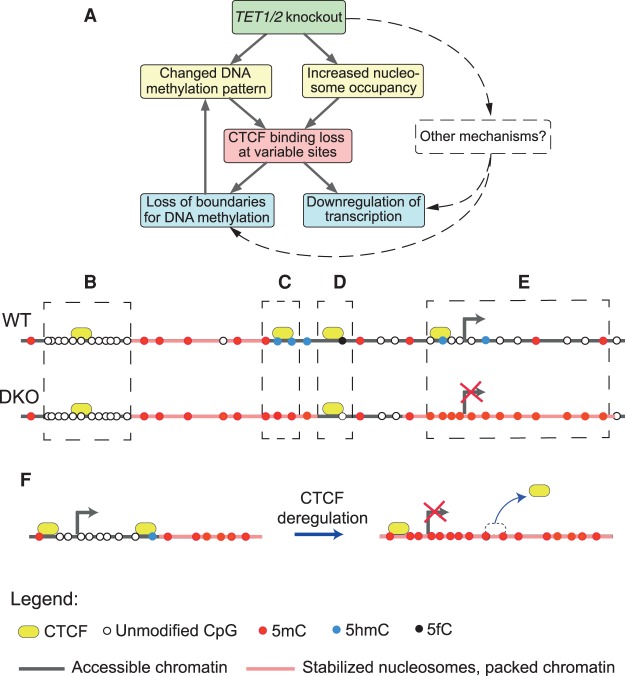
A scheme of different regimes of CTCF sensitivity to DNA modifications. (A) Simplified scheme of the possible causality of events: Tet1/2 knockout leads to the changed DNA methylation pattern and increased nucleosome occupancy. These lead to CTCF binding loss at variable sites. As a result, methylation spreads to larger areas, and neighboring genes are down-regulated. (B) Common CTCF sites were significantly enriched at CpG islands where DNA was unmethylated in both cell types, and CTCF binding was mostly determined by the DNA sequence. (C) CTCF sites marked by 5hmC in WT were predisposed for loss of CTCF binding in DKO cells, which could be accompanied by a 5hmC/5mC switch and the loss of 5hmC. (D) Regions near 5fC sites were more enriched for common than for lost CTCF sites. (E) CTCF loss at promoters and in the vicinity of genes may lead to the spreading of DNA methylation into neighboring regions as a function of the distance from the CTCF site. Genes inside such regions tend to become down-regulated in DKO ESCs. (F) In some cases, methylation of a single CpG inside a CTCF binding site may lead to CTCF removal, or vice versa, and results in the loss of the boundary between methylation microdomains. This process may induce a subsequent change of transcription, as shown for an example genomic region in Supplemental Figure S27.